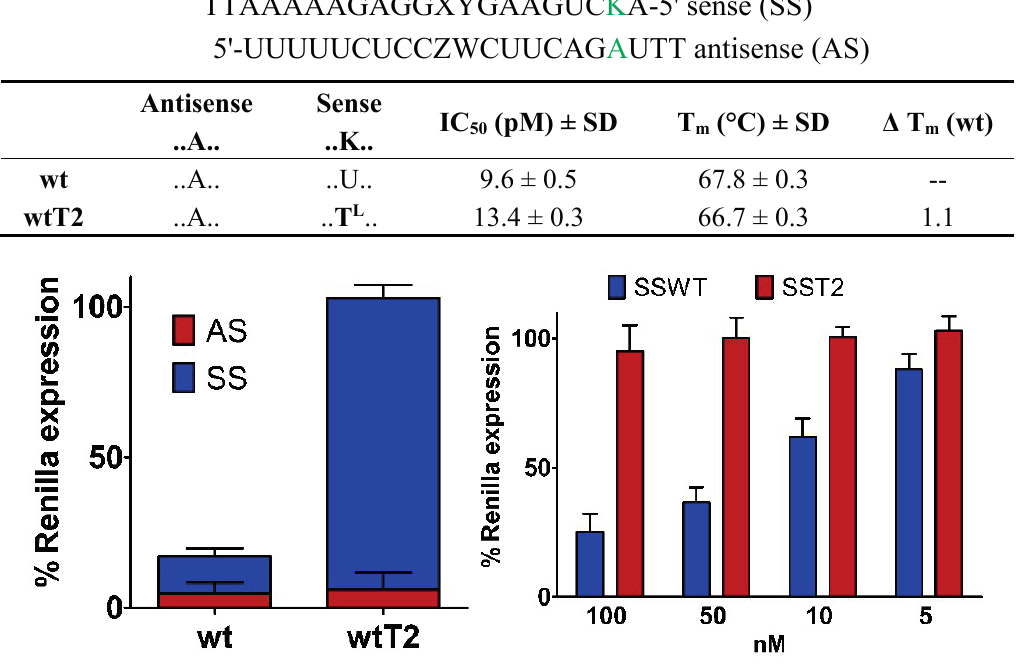
Table 2. Sequence, potency and duplex stability properties comparison between unmodified and L -threoninol terminal modified siRNA.